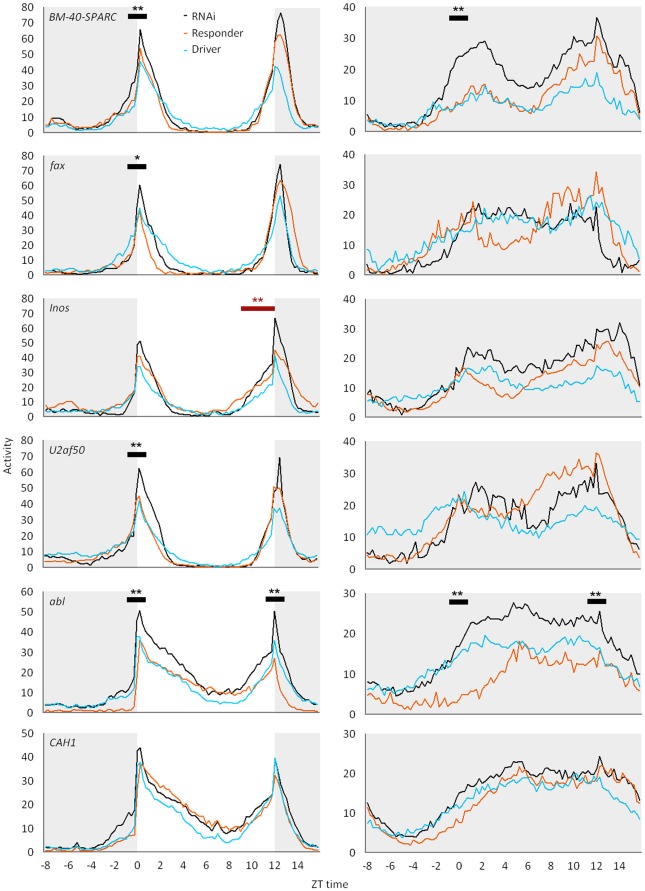
Activity patterns in light-dark (LD) and constant dark following entrainment (DD).Plots show unsmoothed activity averaged across individual flies and the 5-day recording period under LD (left panels) and DD (right panels). Shading indicates dark period. RNAi, Responder and Driver genotypes are described in Methods. All genes were tested in males except for Abl and CAH1, which were tested in females. Significant effects on peak activity are indicated by black bar (asterisks as in Table 1 and 2). Significant effect on anticipatory activity is indicated by a red bar. Additional effects on inactivity for CAH1 (in LD) and BM-40-SPARC (in DD) are not indicated in figure (see Table 1 and 2).